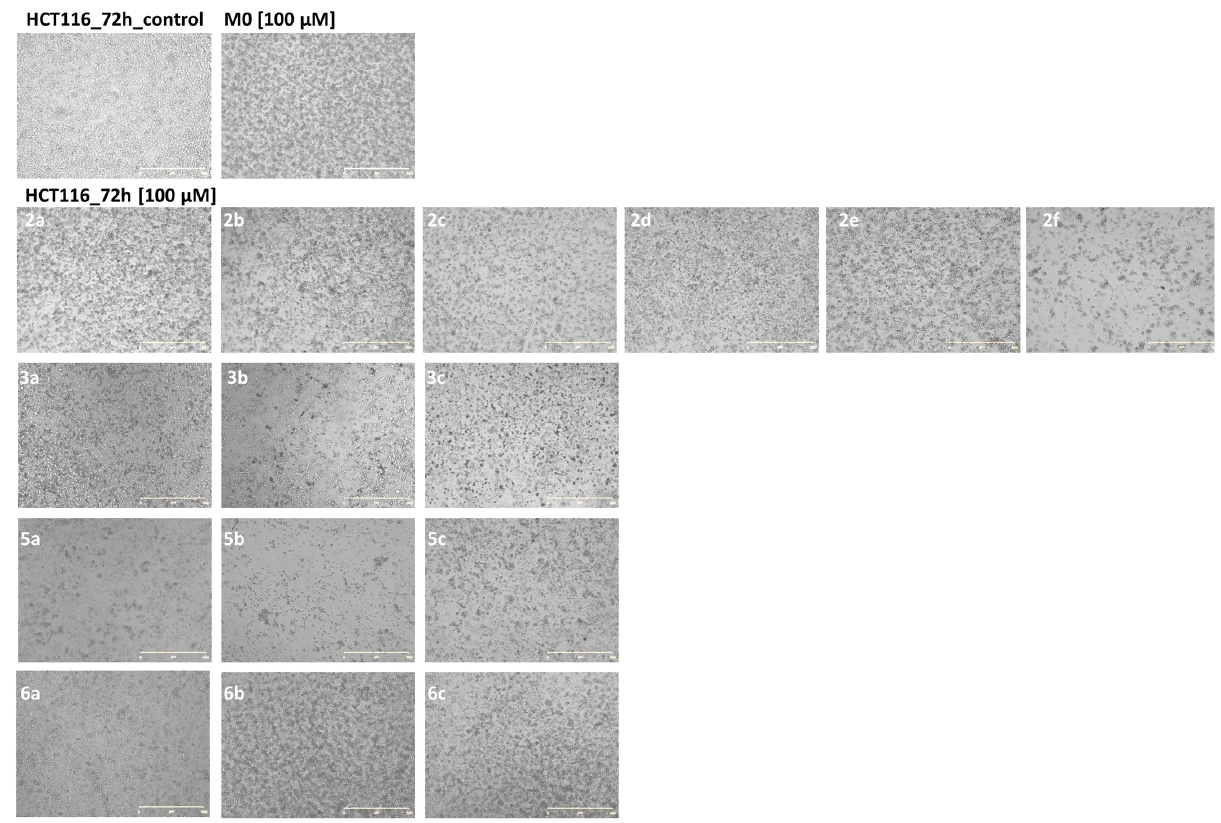
Figure 1. Typical images taken from HCT116 cells after 72 h of exposure to 100 μ M of tested compounds. Juli Fl apparatus (NanoEntek); magnification 4× g ; scale bar 100 μ m.